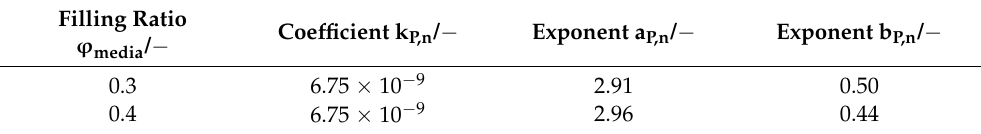
Table 6. Variables for model equation (Equation (13)) to describe the normal power input based on rotational speed n (in min − 1 ) and media size d media (in